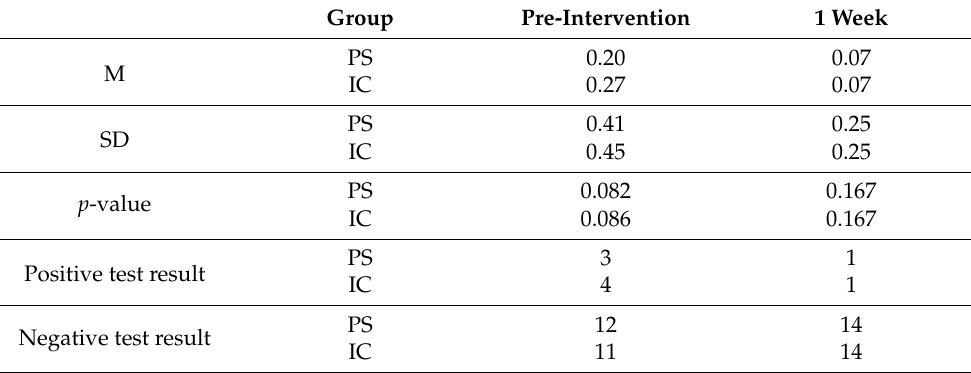
Table 6. Mean (M) and standard deviation (SD), with p -value and Schober test result, by group and time of collection. Group